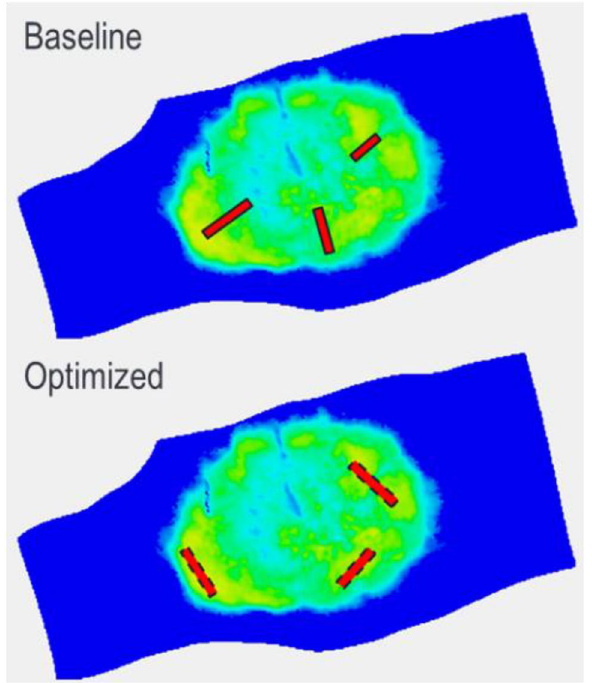
Fig. 14 Infill well locations (red bars) shown on mobile oil probabil‑ ity map at the end of history, baseline FDP design targets (upper), optimized targets